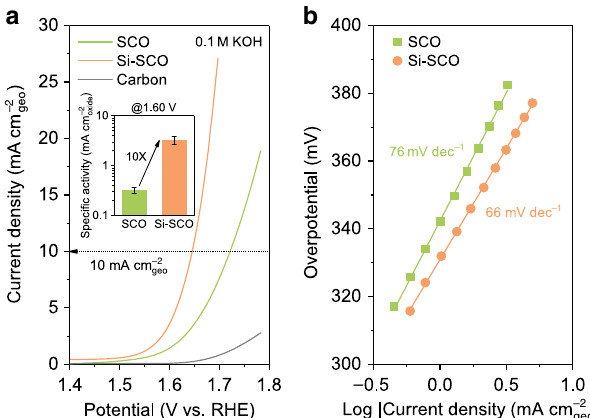
Fig. 2 Electrocatalytic oxygen evolution performance of Si-incorporated strontium cobaltites. a OER kinetic currents (normalised to the geometric surface area of the electrode, in mA cm − 2 geo ) of SCO and Si – SCO collected in an O 2 -saturated 0.1 M KOH electrolyte under ambient conditions. The contribution from the conductive carbon as catalyst support is shown for reference. Inset shows the OER speci fi c activity (normalised to the BET surface area of the oxide catalyst, in mA cm − 2 oxide ) of SCO and Si – SCO at 1.60 V vs. RHE. Error bars are the standard deviations of triplicate measurements. b Steady-state Tafel data for SCO and Si –